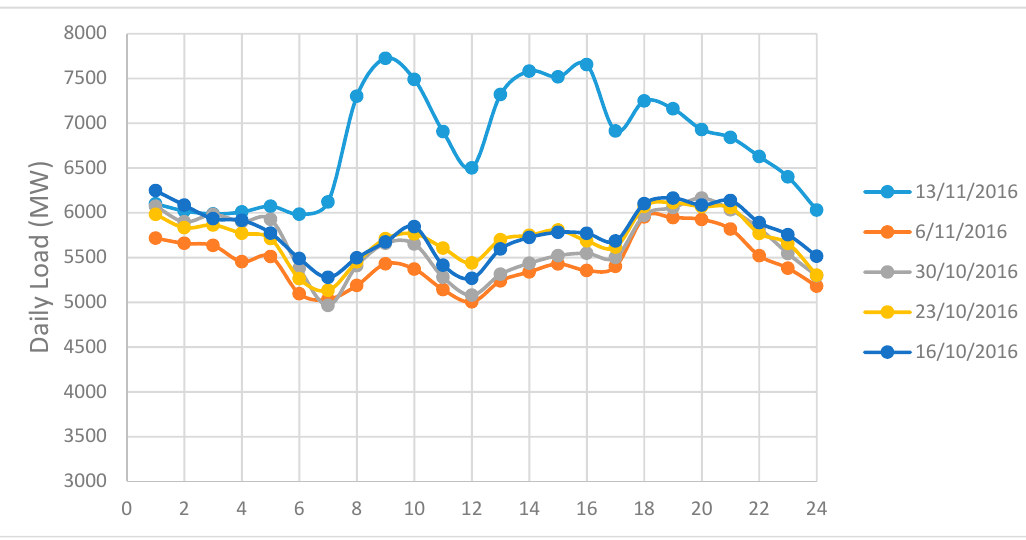
Figure 15. Load pattern of similar days to 20 November 2016.